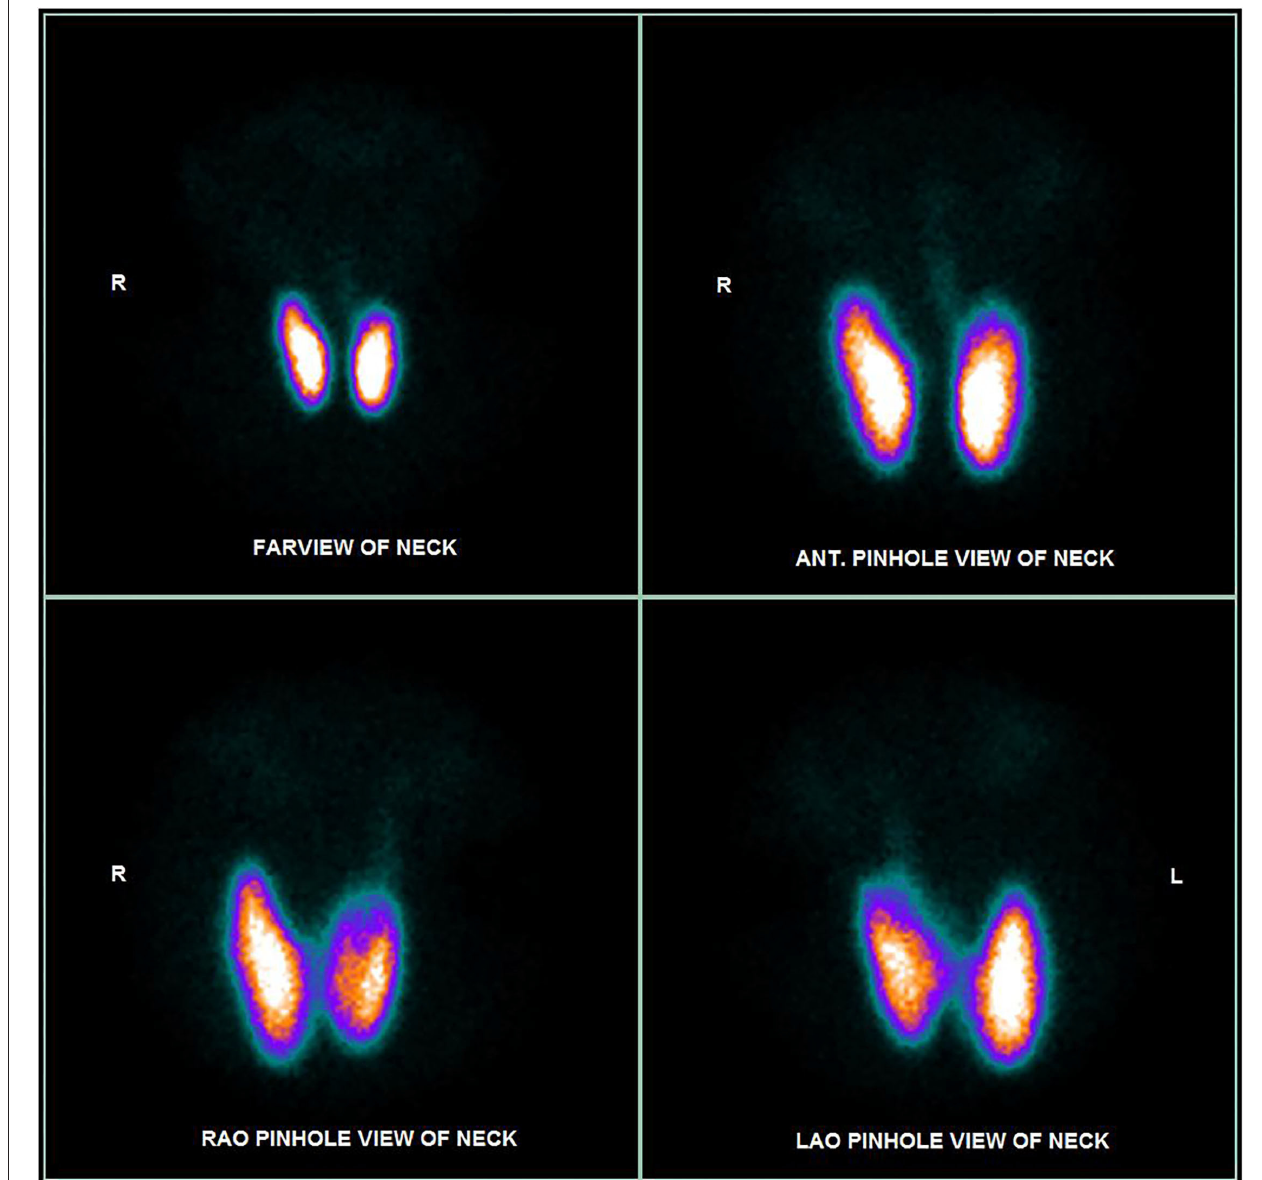
FIGURE 2 | Thyroid ultrasonography at the diagnosis of Graves’ disease of our patient (left panel: both lobes without Doppler; mid panel: right lobe with Doppler; right panel: left lobe with Doppler).